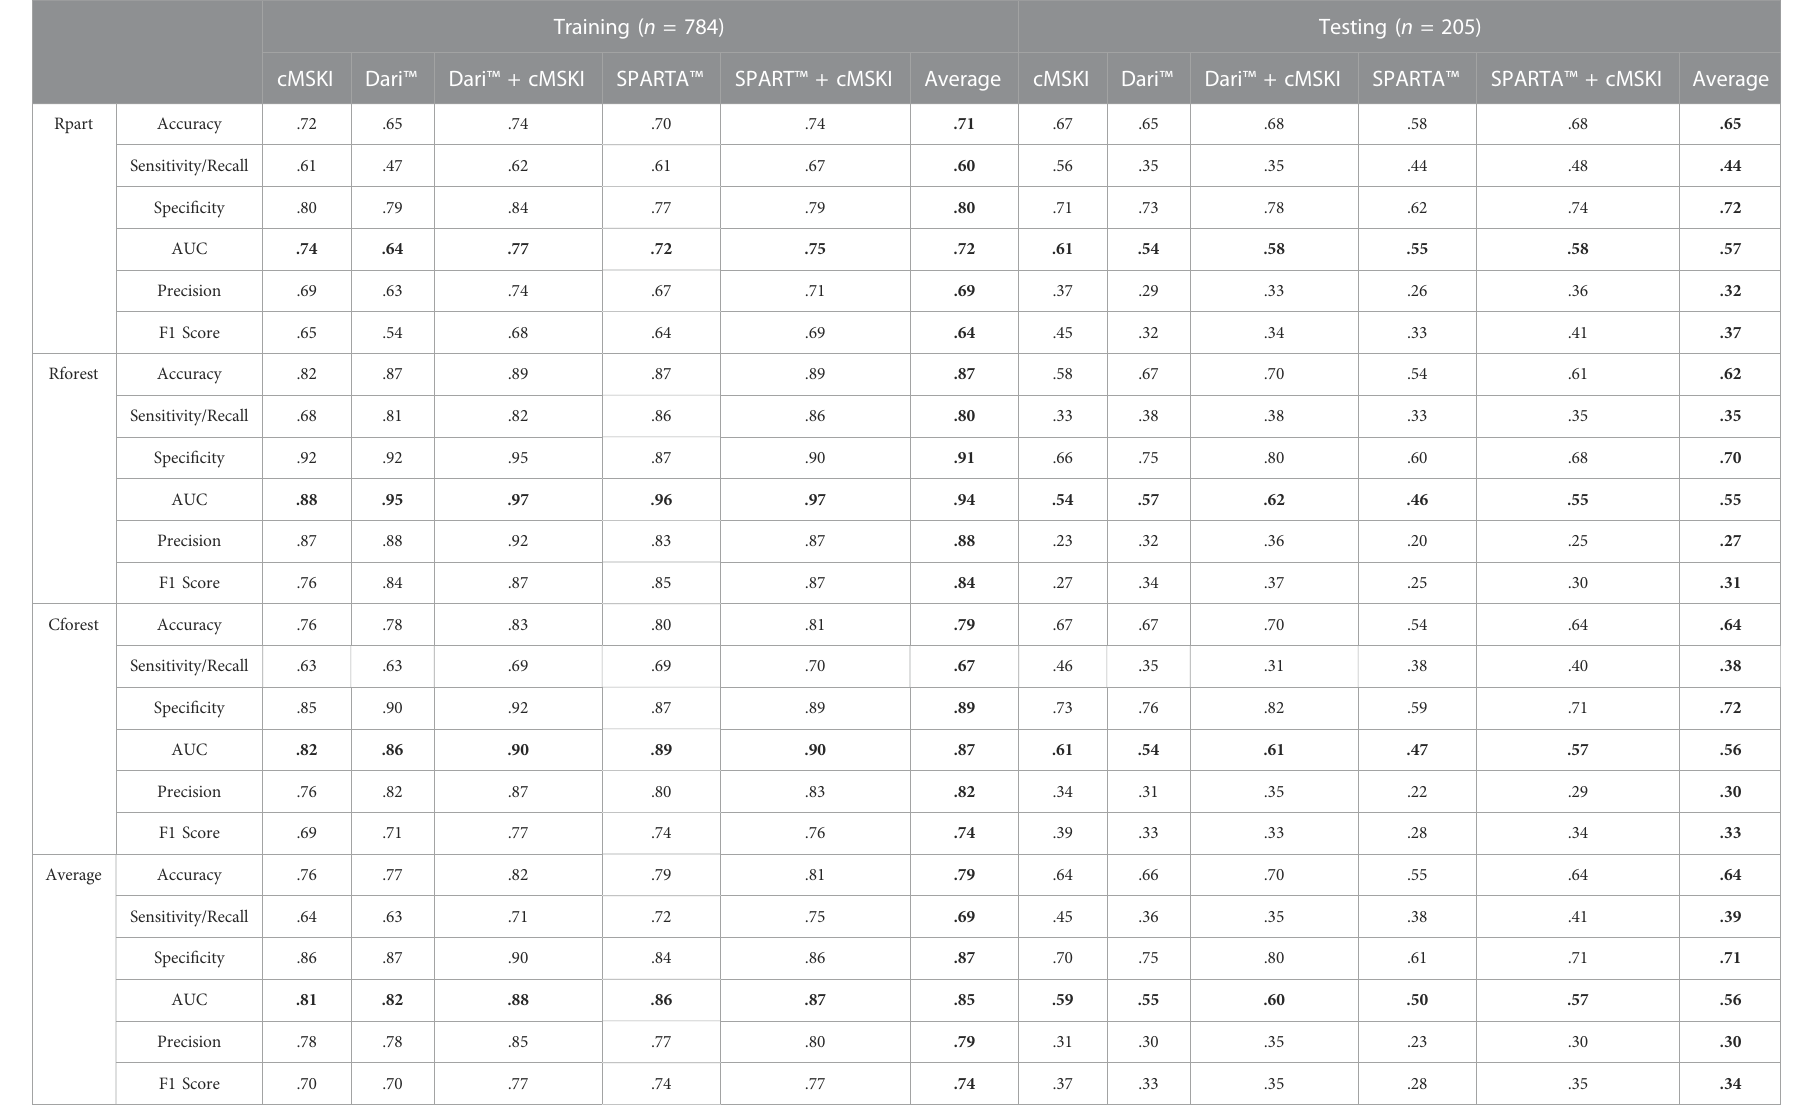
TABLE 4 Training and Testing Model Performance Across all Algorithms and Data